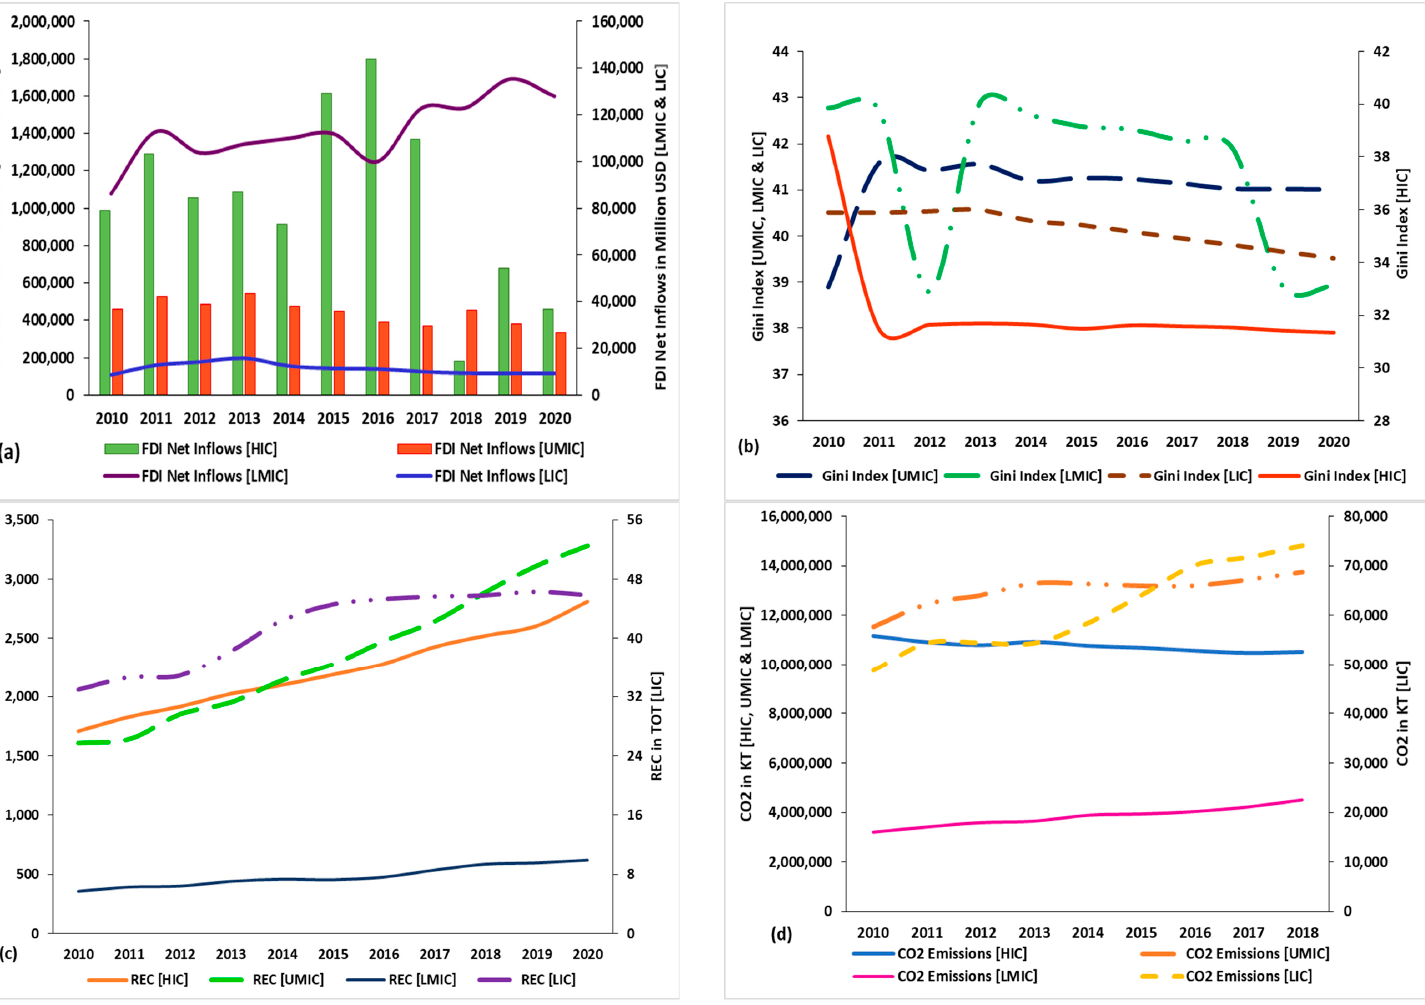
Figure 1. Trends in ( a ) FDI Net Inflows, ( b ) Gini Index, ( c ) REC, and ( d ) CO 2 Emissions across Regions. Source: [3,4].